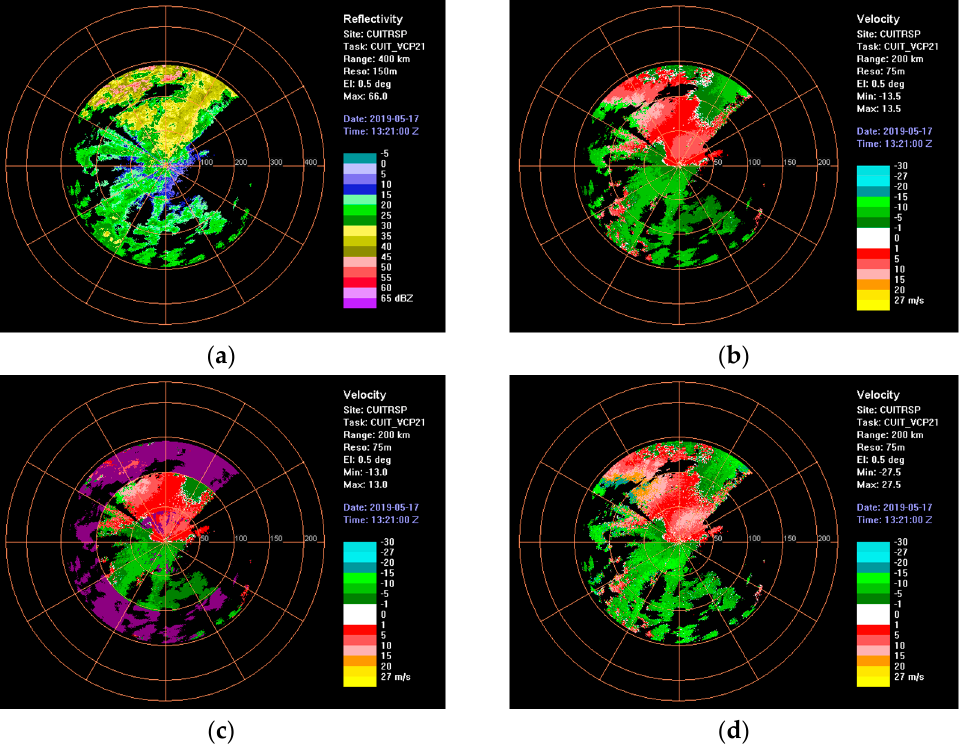
Figure 8. Reference scene base data PPI. ( a ) reflectivity; ( b ) velocity; Simulation radar base data PPI. ( c ) batch mode; ( d ) SZ(8/64) mode.